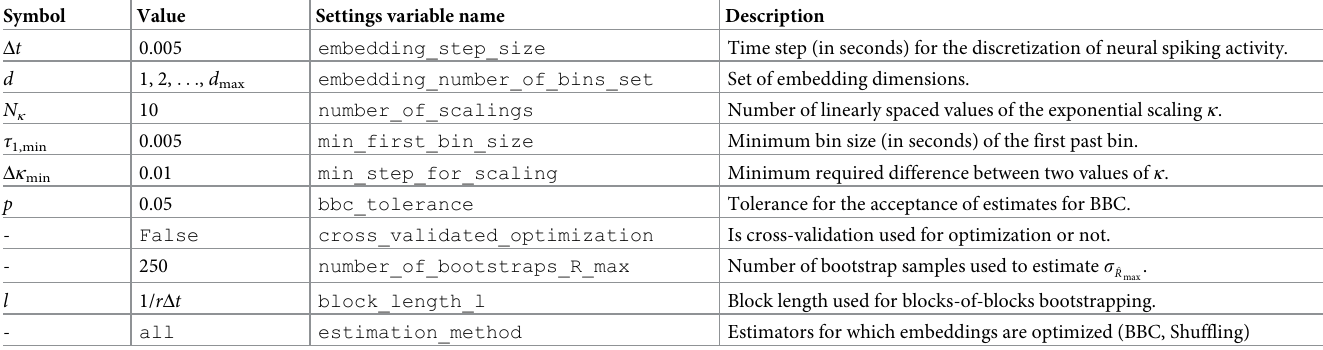
Table 2. Parameters used for embedding